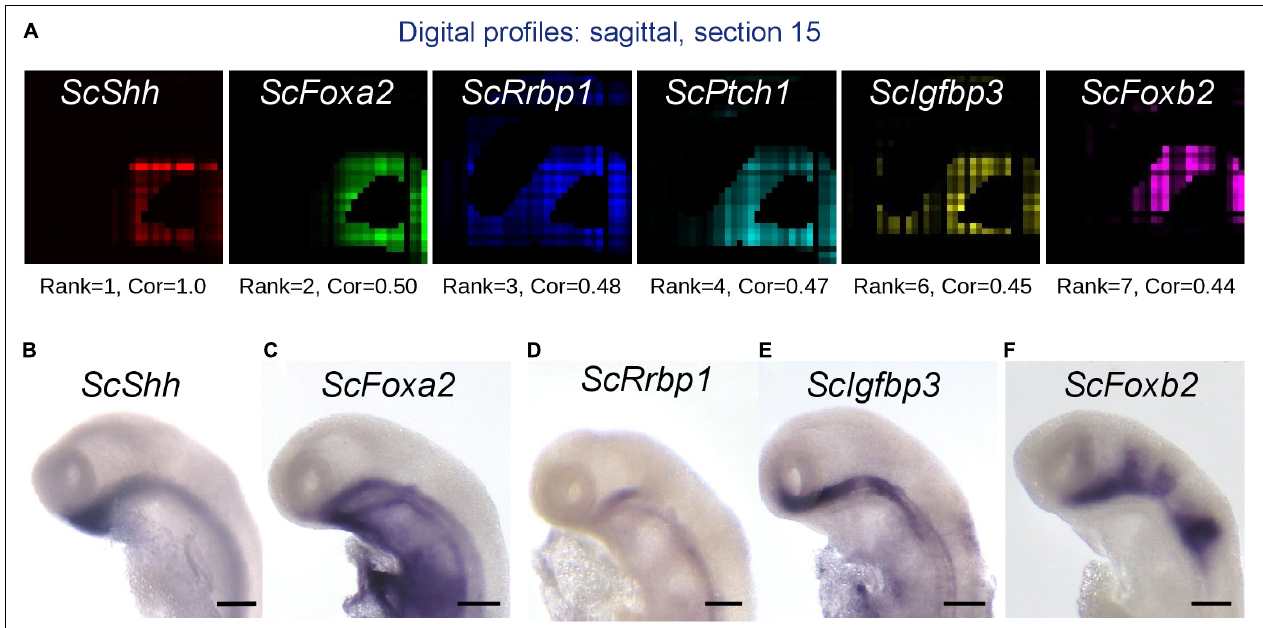
FIGURE 7 | Identification of genes harboring expression correlation with ScShh . (A) Digital profiles on sagittal section number 15 (out of 30, from left to right) of a selection of genes showing a high expression correlation to ScShh (red), ScFoxA2 (green), ScRrbp1 (blue), ScPtch1 (cyan), ScIgfbp3 (yellow), and ScFoxb2 (purple). The rank of each gene in the list of gene models ordered by decreasing correlation to ScShh and the correlation value (Cor) are indicated below each section. (B–F) Left lateral views of stage 17 catshark embryonic heads after ISH using probes for ScShh (B) , ScFoxA2 (C) , ScRrbp1 (D) , ScIgfbp3 (E) , and ScFoxb2 (F) . Scale bars = 200 µ